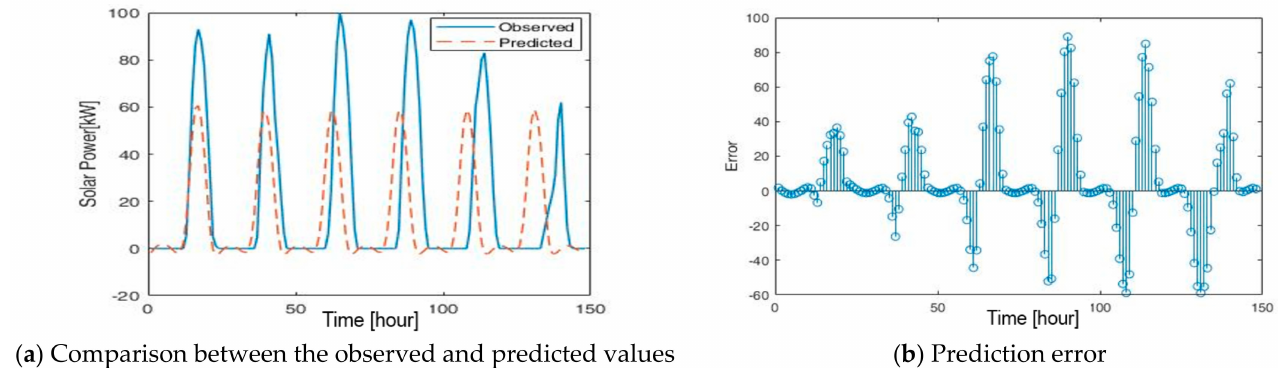
Figure 6. Solar power forecasting using a traditional long short-term memory (LSTM).